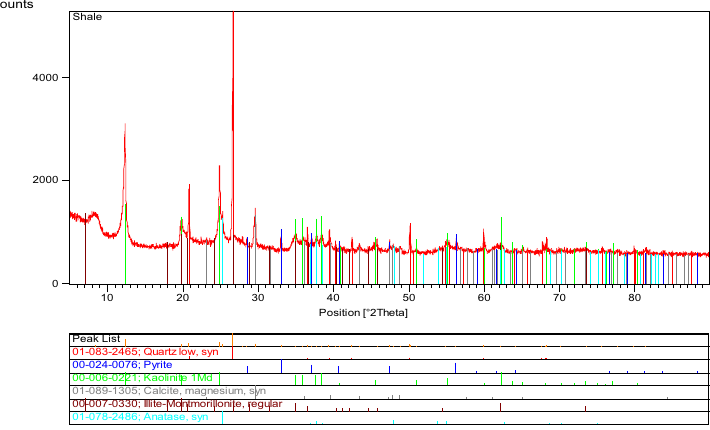
Fig. 4 XRD analysis of the shale